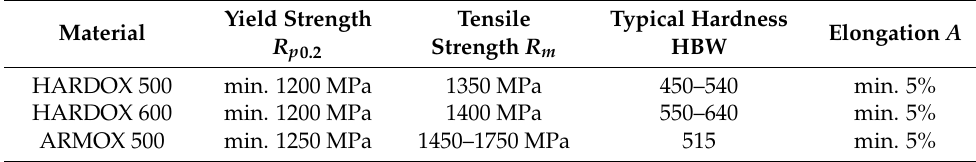
Table 5. Basic mechanical properties of HARDOX 500 steel (SSAB datasheets)